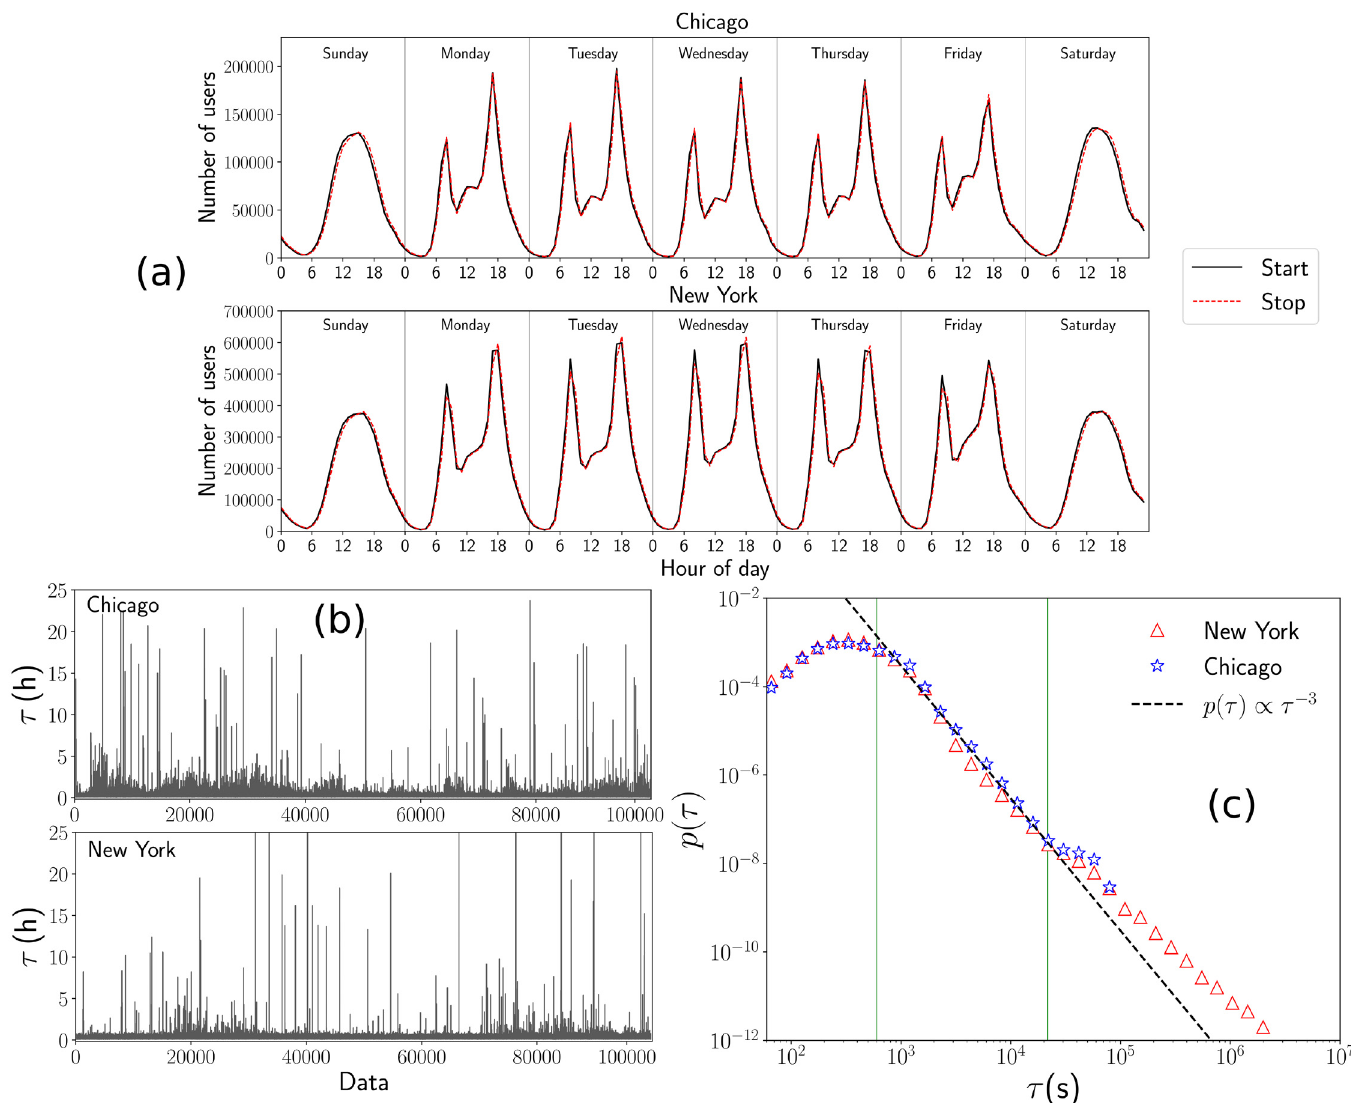
Fig 1. Temporal patterns of users in bike-sharing systems in Chicago and New York. In (a) we depict the frequency of users grouped according to the weekday and the hour registered at the start and end of each trip. Continuous lines represent the activity in the stations considering the starting time and dashed lines show the results for the registers at the end of the travel. On the other hand, in (b) we present the time τ elapsed between the start and end of a trip. We consider 10 5 successive events in both systems. In (c) we show the results for the statistical analysis obtained with the probability density p ( τ ) for the duration time of each trip; the complete databases are analyzed by using logarithmically spaced bins. The dashed line in (c) represents the inverse power law p ( τ ) / τ − 3 and the vertical lines denote two values used as reference at τ = 10 min and τ = 6